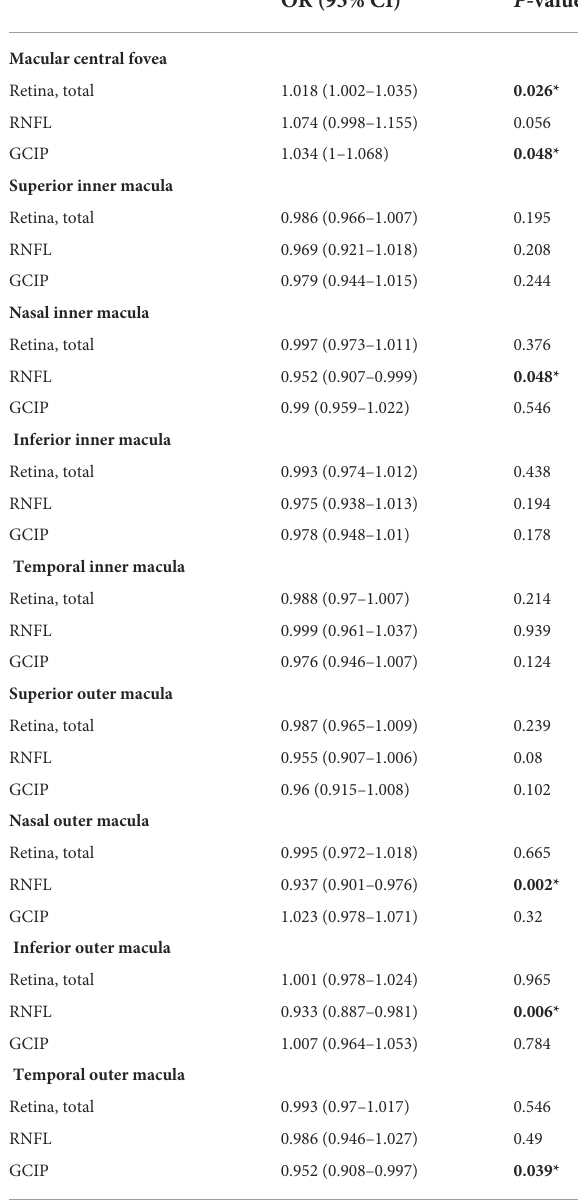
TABLE 3 Logistic regression analysis of retinal thickness in different subfield-related factors for higher white matter hyperintensity volume.